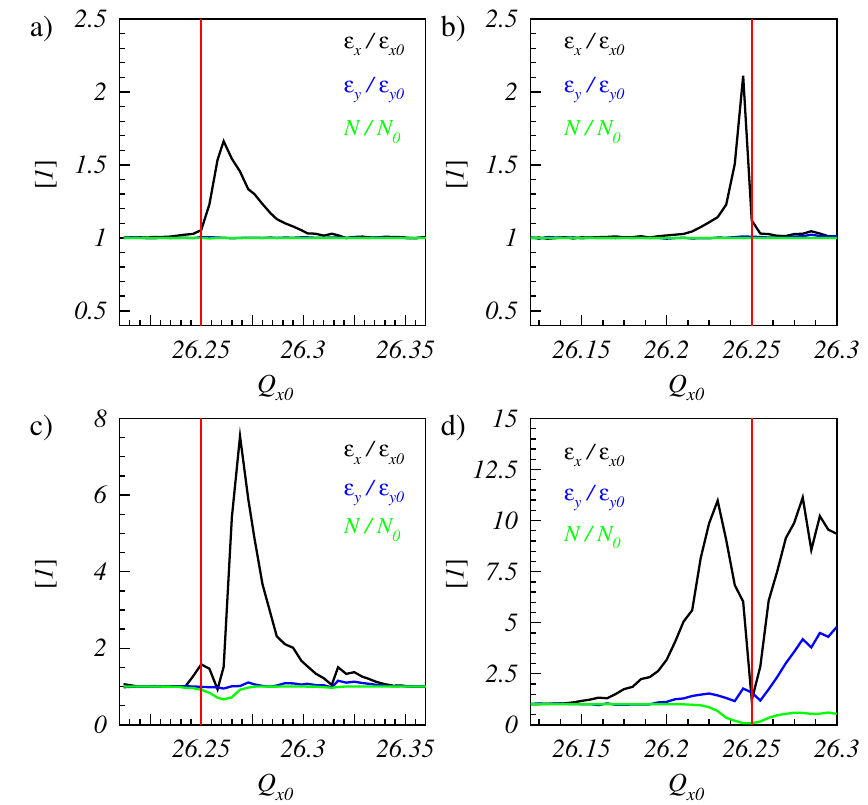
FIG. 10. (Color) Beam response and survival with longitudinally frozen motion (top) pure SC (left), pure EC (right); and including longitudinal motion (bottom) with only SC (left), with only EC (right). In all these simulations Q y